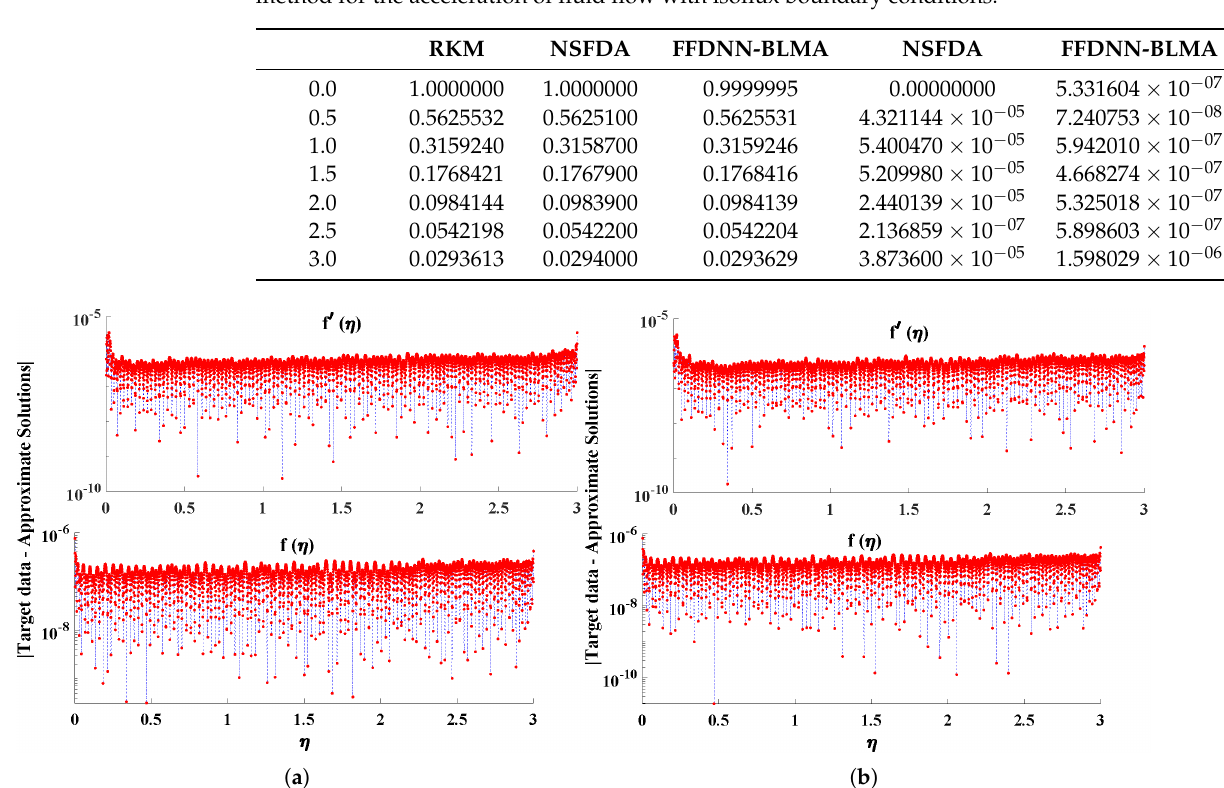
Table 5. Evaluation of the error values of the approximate solutions estimated by the designed method for the acceleration of fluid flow with isoflux boundary conditions.